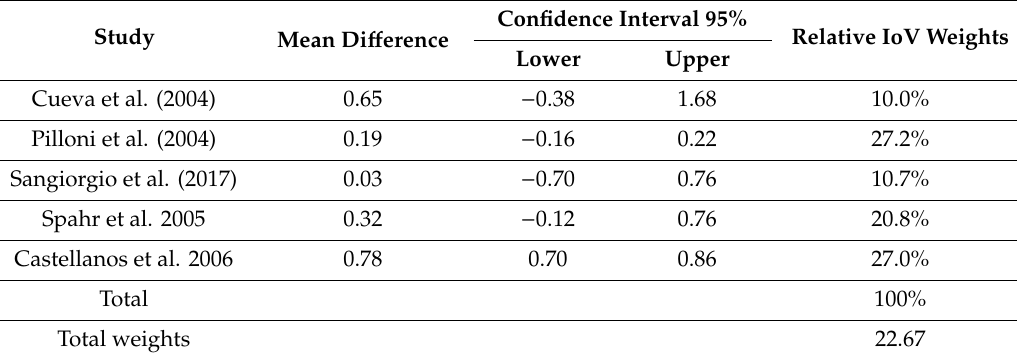
Table 4. Mean Di ff erence and Confidence Interval (95%) are expressed in mm.